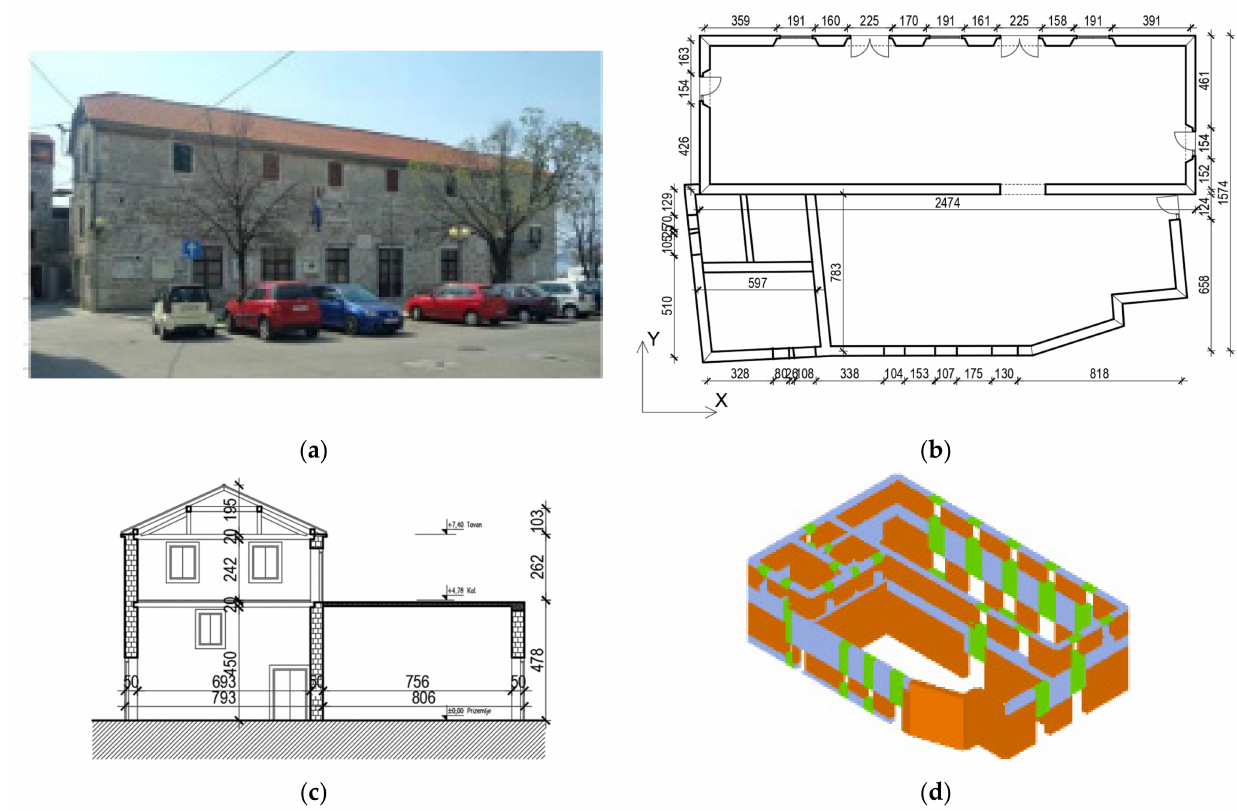
Figure 12. Public library: ( a ) photo of the building; ( b ) ground floor plan; ( c ) section view; ( d ) structural model used for non-linear seismic